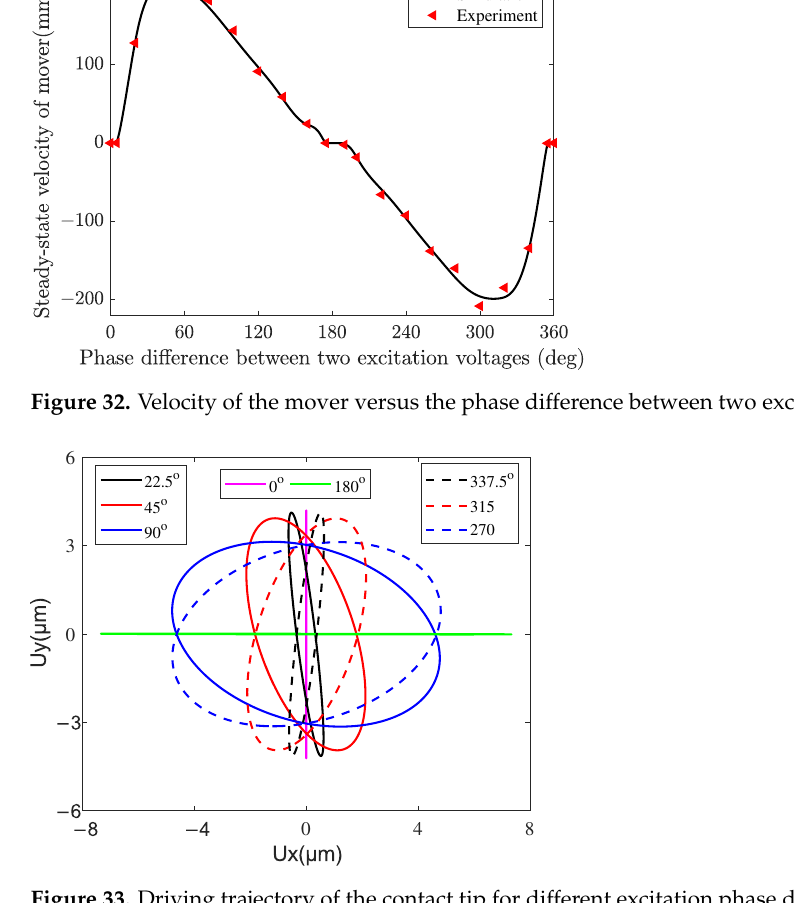
Figure 33. Driving trajectory of the contact tip for different excitation phase